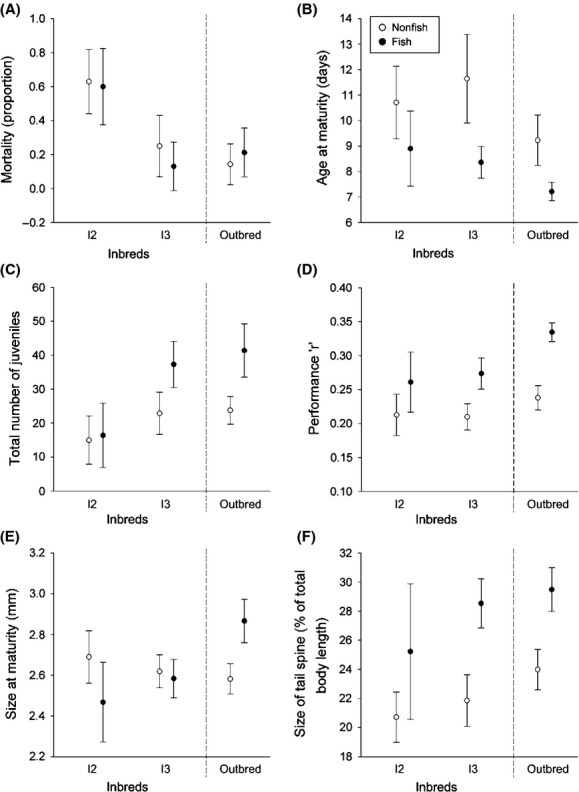
Mortality (A), age at maturity (B), total number of juveniles (C), performance “r” (D), size at maturity (E), and size of the tail spine (F) of two inbred subpopulations generated as selfed offspring of clones isolated from Langerodevijver (left and middle panel in each graph) and a group of outbred clones directly hatched from Langerodevijver (LRV) (middle panel of each graph). Life history traits as quantified in a life table experiment in the absence (open symbols) and presence (closed symbols) of fish kairomones. Error bars represent 2× standard error of the mean.